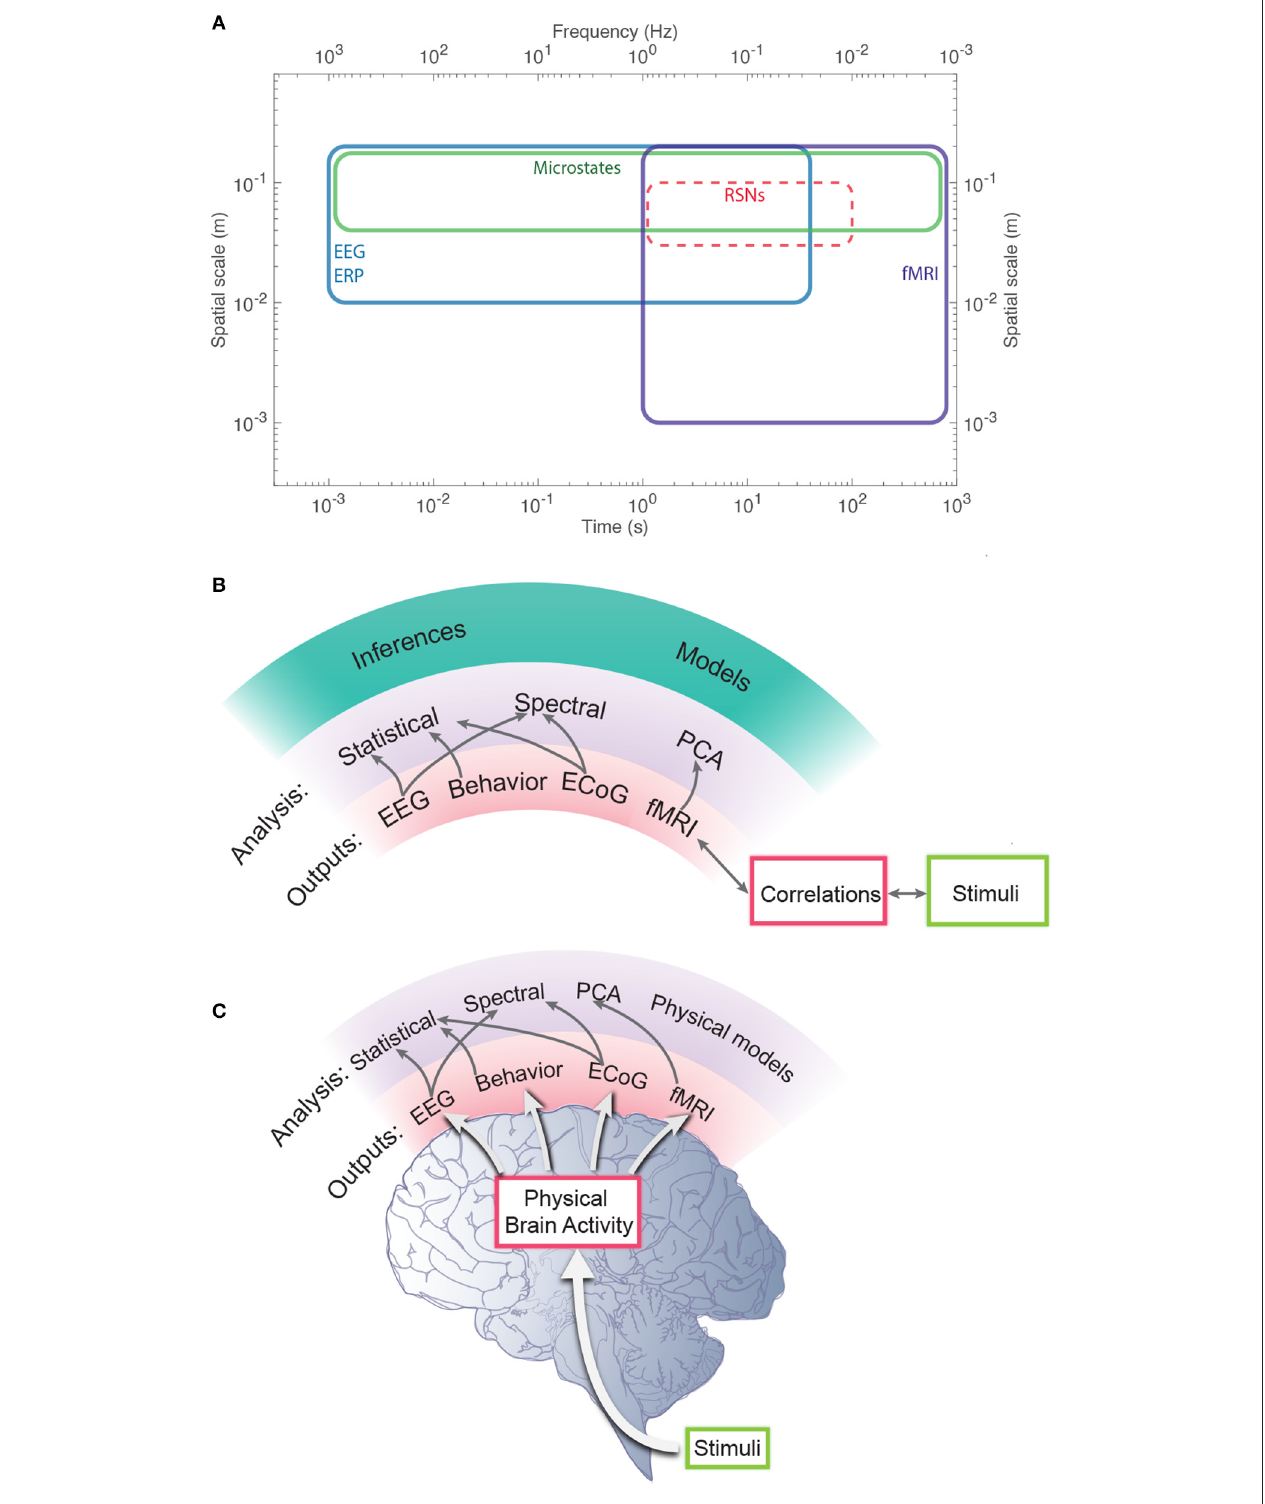
FIGURE 1 | Schematic of brain observations and analysis. (A) Approximate spatiotemporal scales spanned by EEG, ERP, and fMRI observations, and by phenomenological resting state networks and microstates. (B) Phenomenological and statistical links between measurements and constructs. (C) Physical activity generates the links seen in (B)